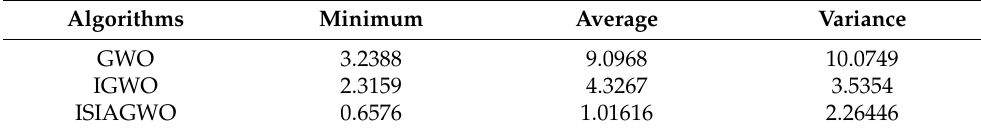
Table 5. Values of the fitness function for the three algorithms.